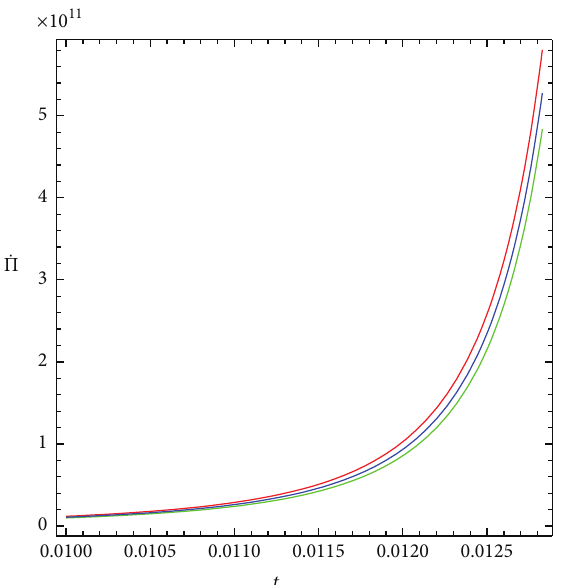
Figure 7: Time evolution of bulk viscous pressure